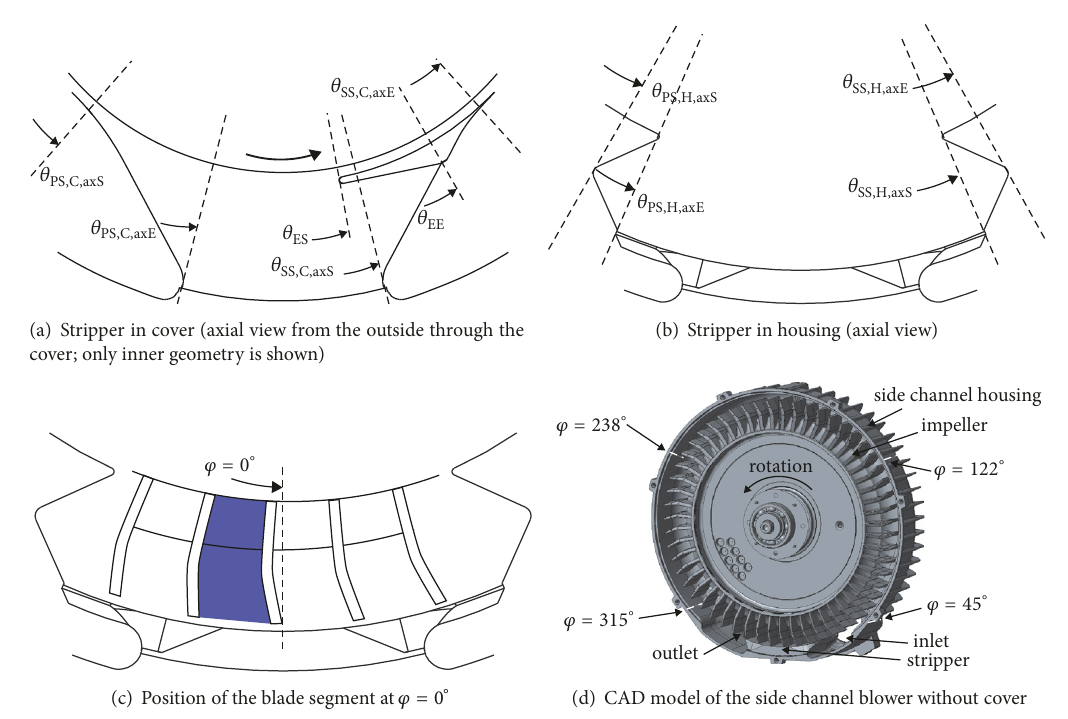
Figure 9: Stripper geometry, 0 ∘ -position of blade segment and CAD model of the opened side channel blower.